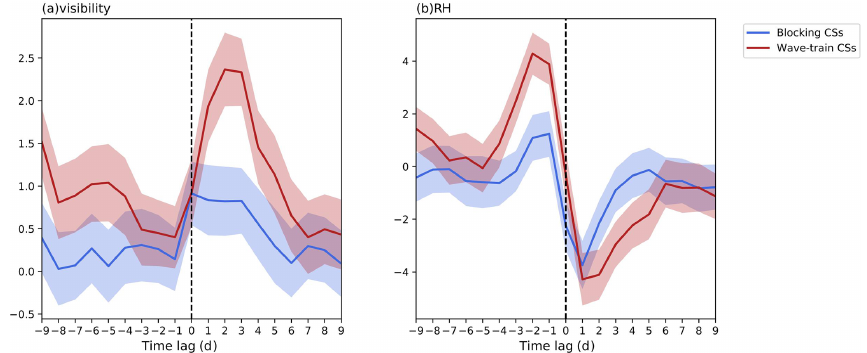
Figure 5. Regional averaged (a) visibility anomalies (km) and (b) RH anomalies (%) over EC during 9d before and after the outbreak of the blocking CSs (blue lines) and wave-train CSs (red lines), respectively. Shading represents ± 1 standard deviation among the CSs.